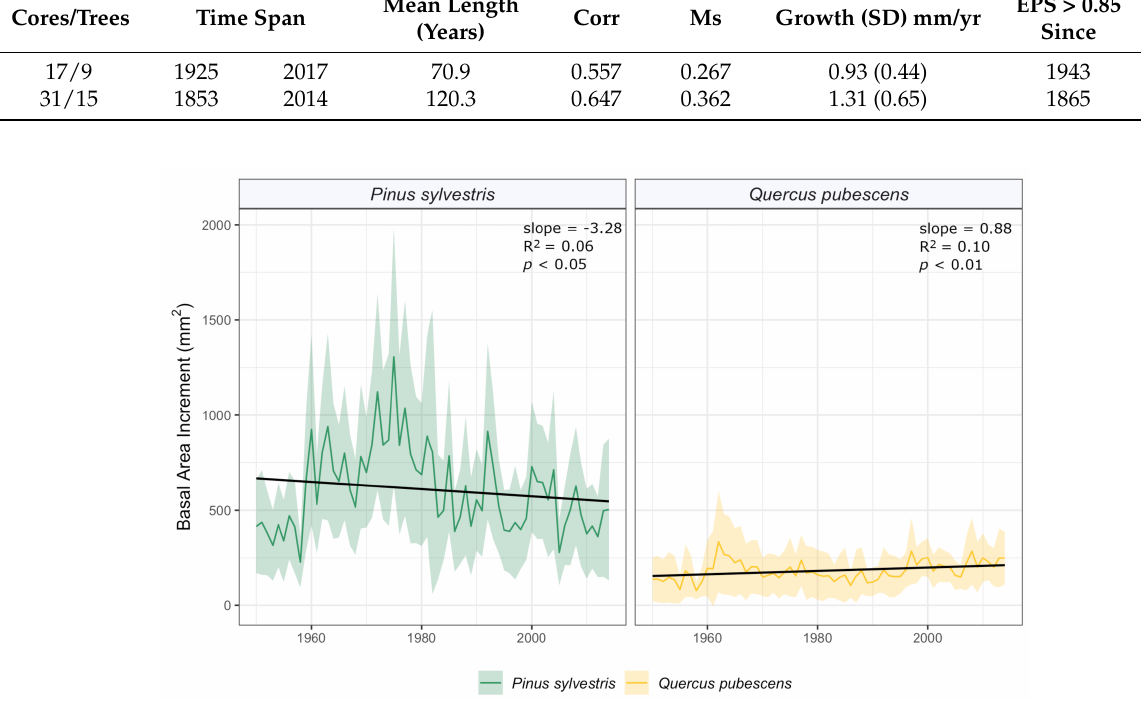
Figure 5. Mean basal area increments of Scots pine and pubescent oak for the period 1950–2014. Shading indicates ± SD. Black lines indicate the least-square